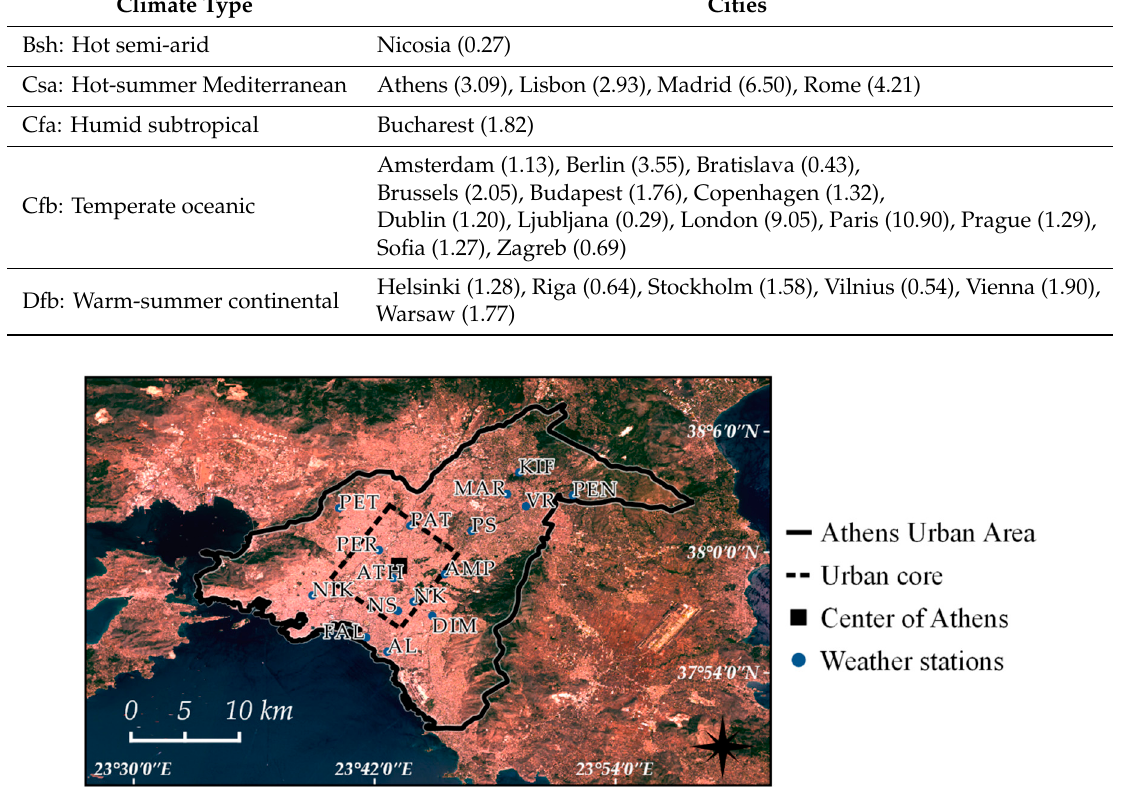
Figure 2. Study domain of Athens and the location of the meteorological stations used in this study; the station codes are given in Section 2.4. Base map: Landsat 8 Operational Land Imager (OLI), true color composite image for 28 June 2017.